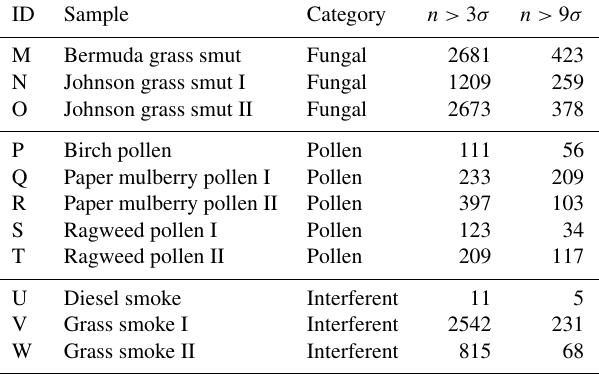
Table 2. The number of particles remaining after a fluorescent threshold was applied for each of the non-bacterial samples col- lected in 2008.